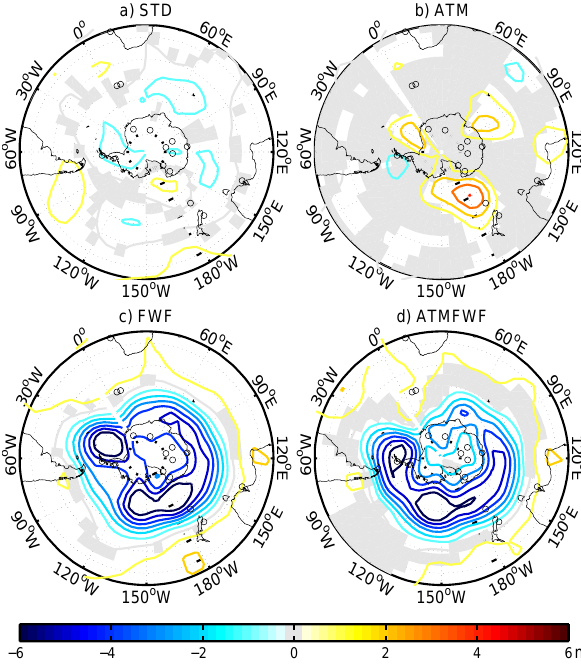
Fig. 3. Difference of annual geopotential heigh at 800hpa (in m) be- tween 8 and 10ka (8ka minus 10ka). (a) STD, (b) ATM, (c) FWF, (d) ATMFWF. Grey areas correspond to nonsignificant differences (99% Student t